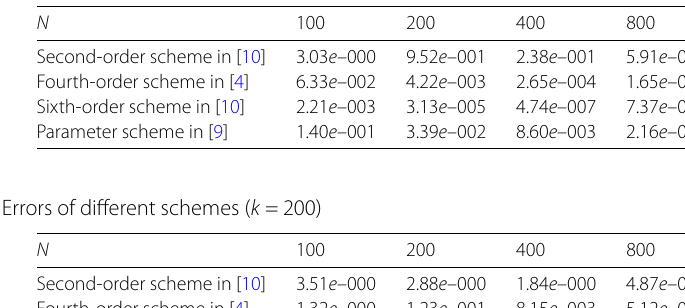
Table 4 Errors of different schemes ( k = 100)